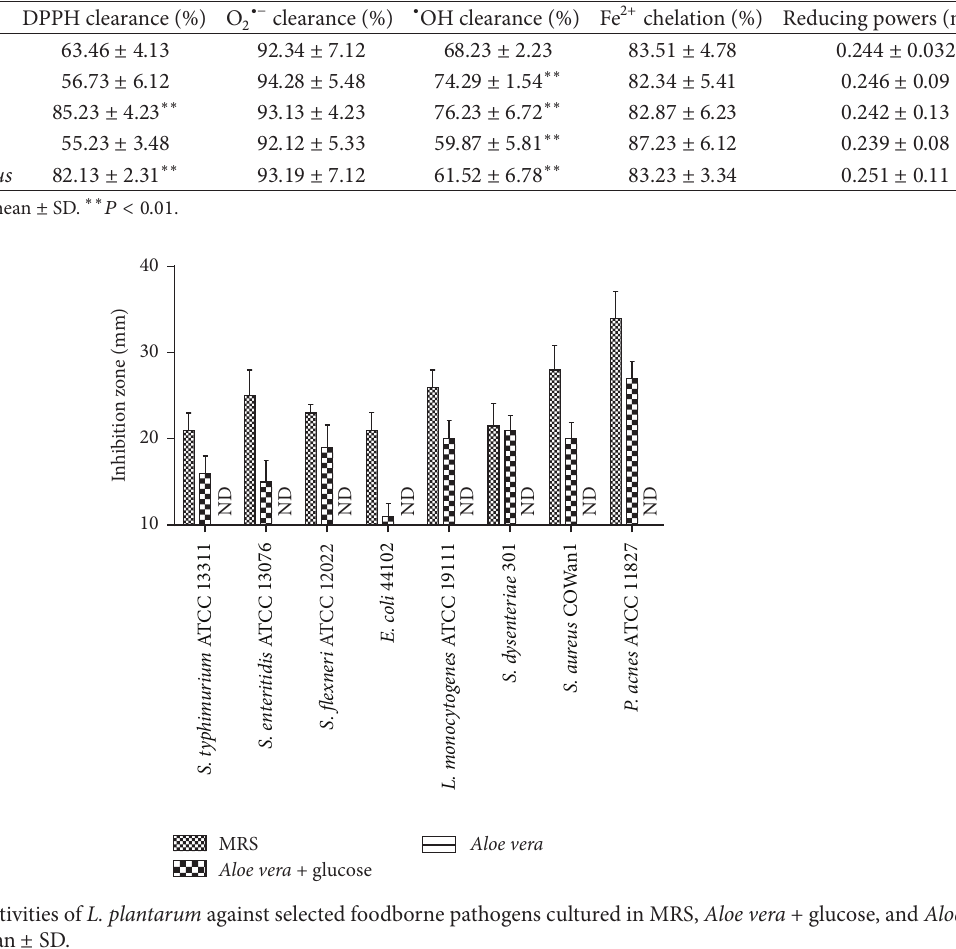
Table 1: The antioxidant activity of the Aloe vera , Aloe vera + B. longum , Aloe vera + L. plantarum , Aloe vera + L. rhamnosus GG, and Aloe vera + S. thermophilus .